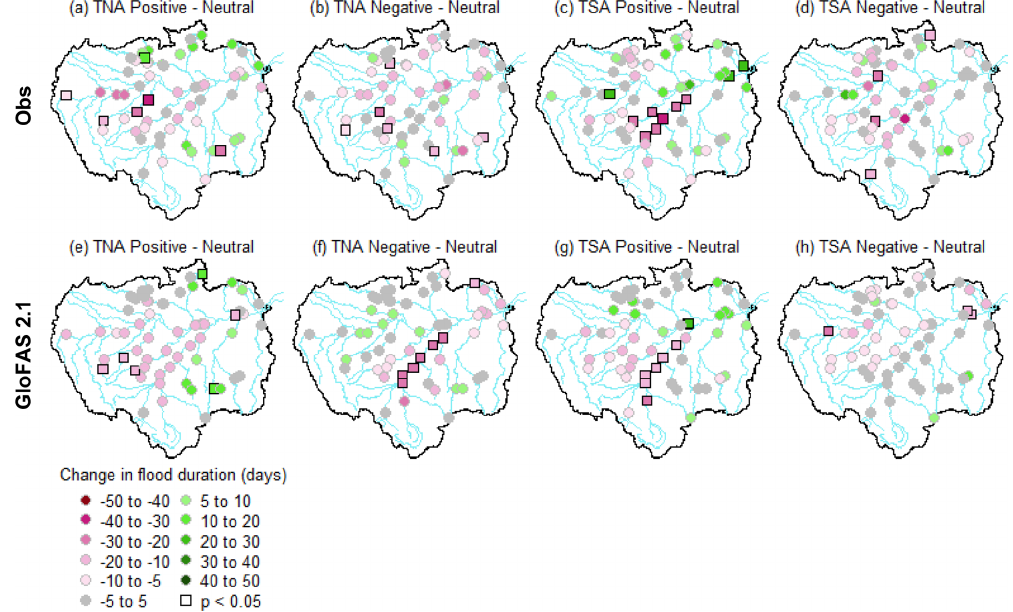
Figure 10. Changes in flood duration (i.e. mean number of days river flows exceed the 95th percentile of each station or grid point clima- tology) for different phases of tropical Atlantic indices. (a, c, e, g) Positive with respect to neutral years. (b, d, f, h) Negative with respect to neutral years. Panels (a–d) represent changes for observations and panels (e–h) show changes for GloFAS 2.1 streamflow reanalysis data. Pink (green) points represent decreases (increases) in the number of days spent above the 95th percentile compared to neutral conditions. Significant results at the 95% confidence levels are denoted using a square (i.e. p < 0 .